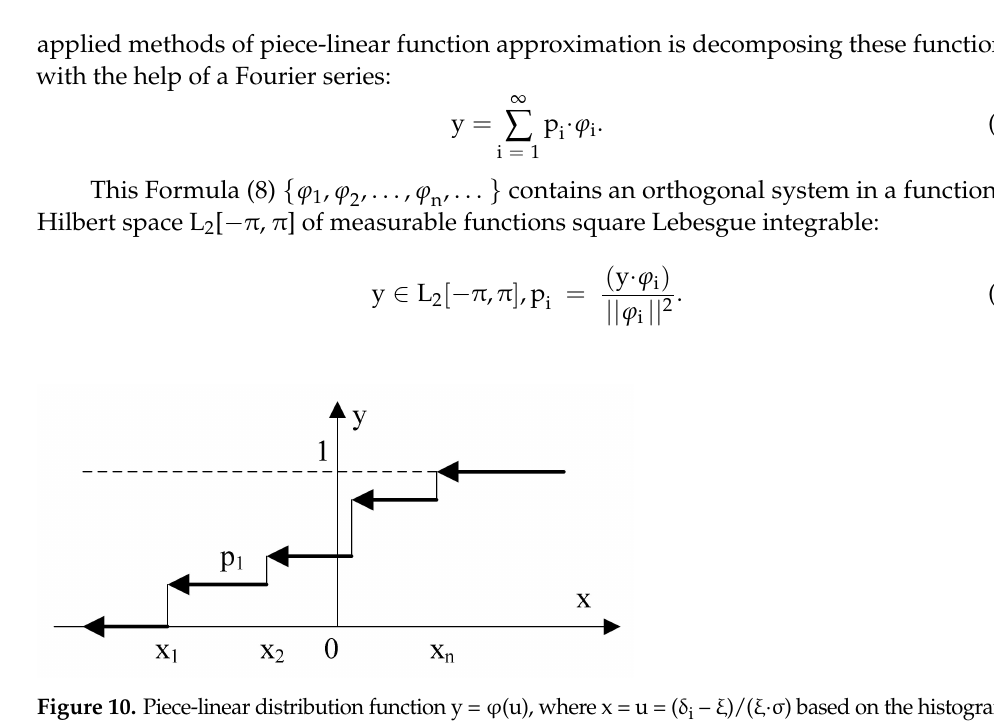
Figure 10. Piece-linear distribution function y = ϕ (u), where x = u = ( δ i – ξ )/( ξ · σ ) based on the histogram. The orthogonal system is frequently presented by means of the trigonometric system 2 π —periodic functions { 1, sin nx, cos nx; n ∈ N }